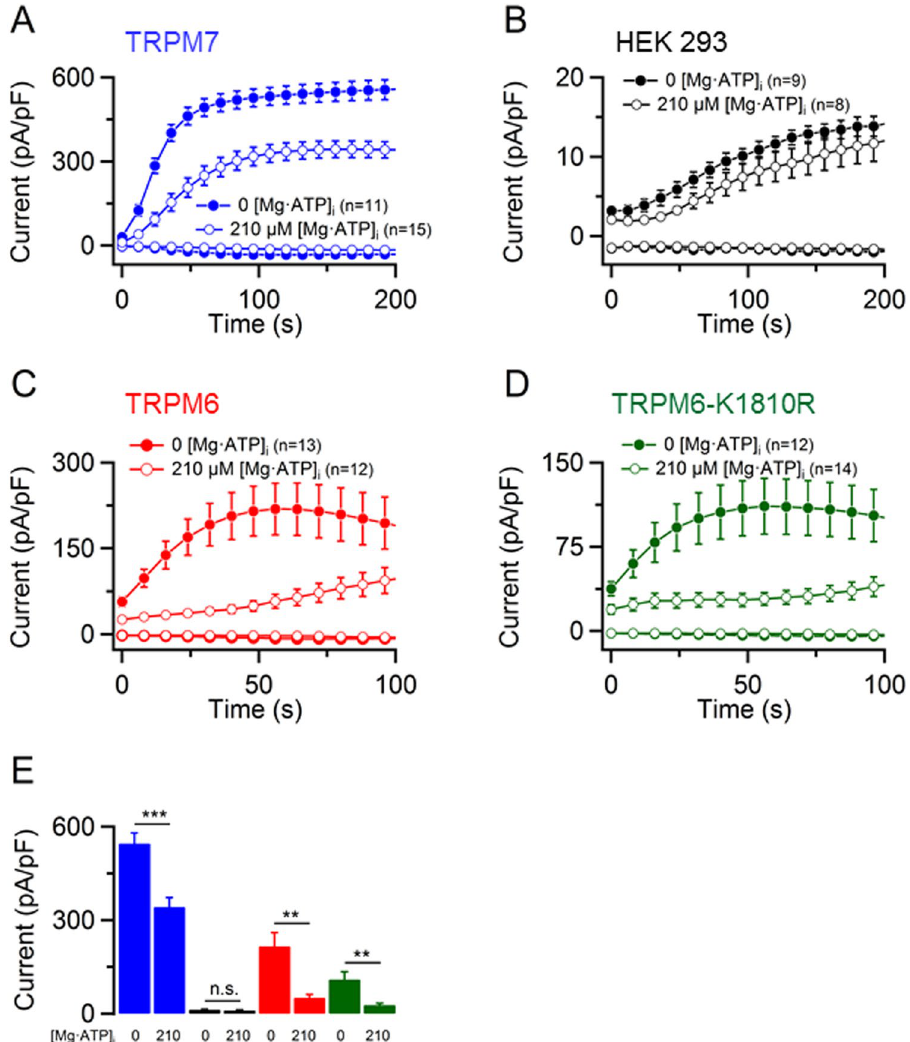
Figure 7. Effects of cytosolic Mg·ATP on mTRPM6 and mTRPM7 currents. ( A ) Whole-cell currents (mean ± SEM) measured in mTRPM7-transfected HEK 293 cells ( A ), untransfected cells ( B ), or cells transfected either by wildtype mTRPM6 ( C ) or mTRPM6-K1810R variant ( D ). Cells were perfused either with the standard [Mg 2 + ] i -free intracellular solution or with a solution containing 210 µ M Mg·ATP (10 µ M free Mg 2 + ). ( E ) Bar graphs of outward currents ( − 80 mV) shown in ( A – D ). Current amplitudes (mean ± SEM) were extracted at time intervals when the currents were maximally induced by the Mg 2 + -free intracellular solution as follows: at 200 s for mTRPM7 (blue) and untransfected cells (black), 50 s for wildtype mTRPM6 (red) and mTRPM6-K1810R (green). n, number of cells measured; n.s., not significant; ** P < 0.01; *** P < 0.001 (two- tailed